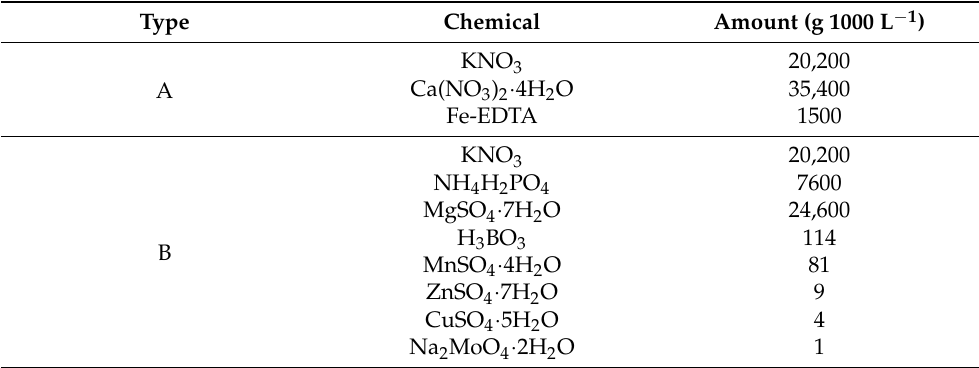
Table 1. Nutrient solution components for cherry tomatoes used in this study.